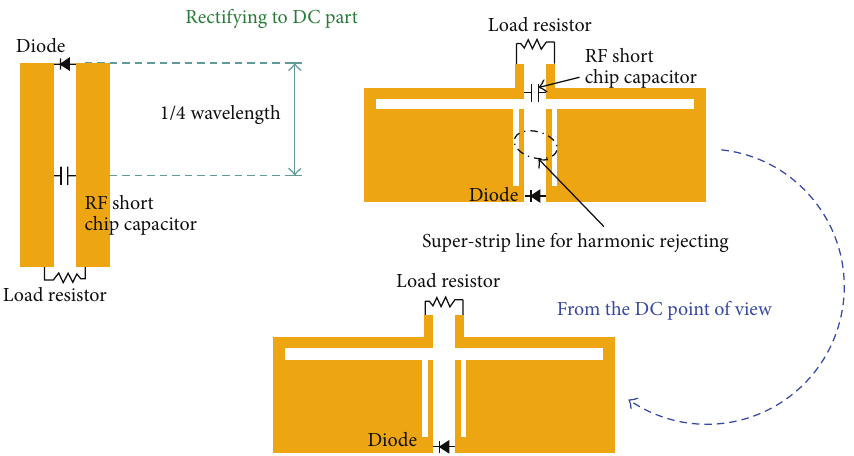
Figure 6: Schematic of proposed highly integrated rectenna working to deliver the DC power to the load resistor.